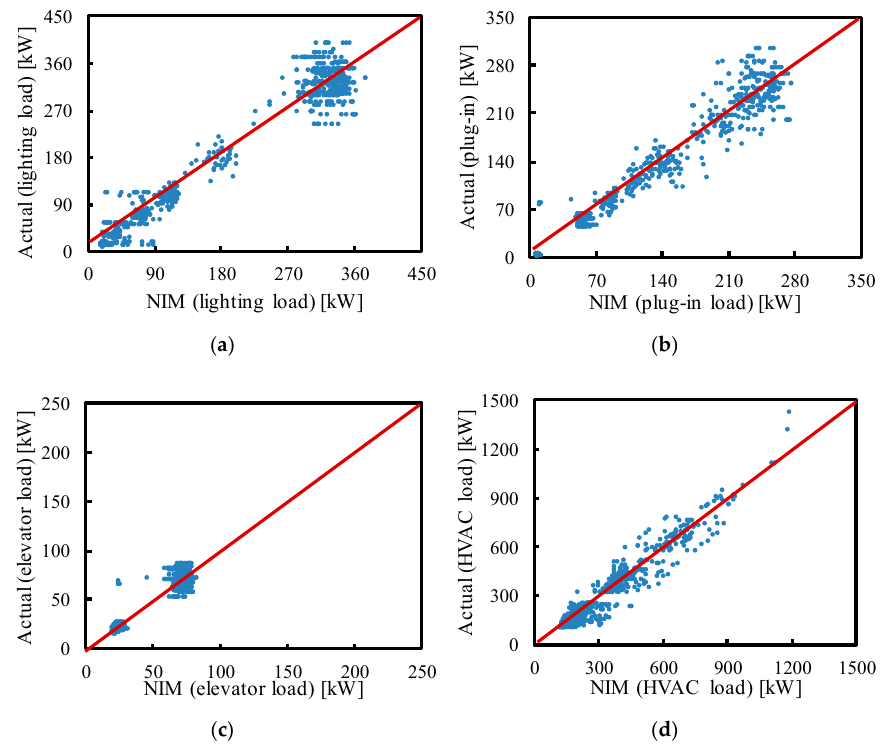
Figure 9. Testing results of the NIM model based on Approach III: ( a ) the comparison results of lighting system load; ( b ) the comparison results of plug-in system load; ( c ) the comparison results of elevator system load; ( d ) the comparison results of HVAC system